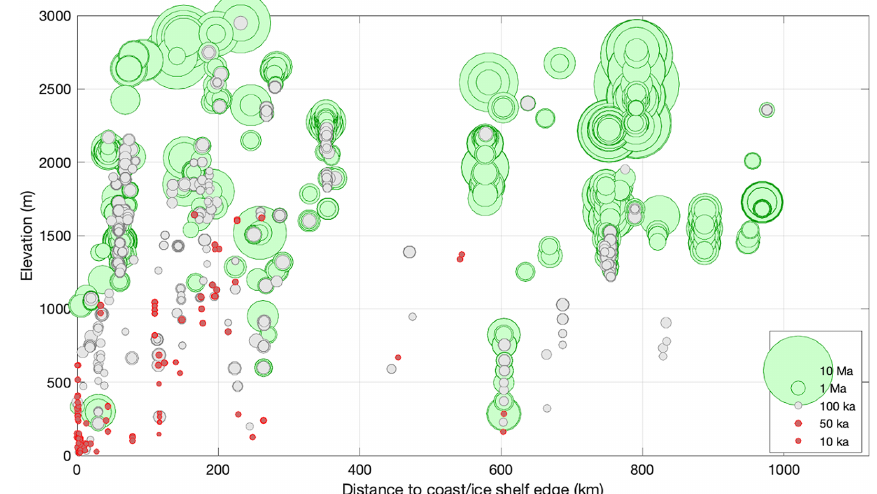
Figure 8. Geographic distribution of bedrock exposure ages in Antarctica compiled in the ICE-D: ANTARCTICA database. Each circle represents a bedrock sample with at least one cosmogenic-nuclide measurement, and the size of the circle indicates the apparent exposure age of the surface calculated from that measurement. The “apparent exposure age” is the exposure age of the surface given the assumption that the surface has been exposed continuously for a single period. As the majority of these samples have been repeatedly covered by ice, the apparent exposure age is a minimum limit on the duration of the exposure history recorded by a sample. Green denotes samples with apparent exposure ages > 1Ma, and red denotes samples with apparent exposure ages < 50ka. Samples that record multimillion-year exposure histories are common at elevations above approximately 1500m, are ubiquitous at high-elevation inland locations, and are rare at lower-elevation coastal sites.